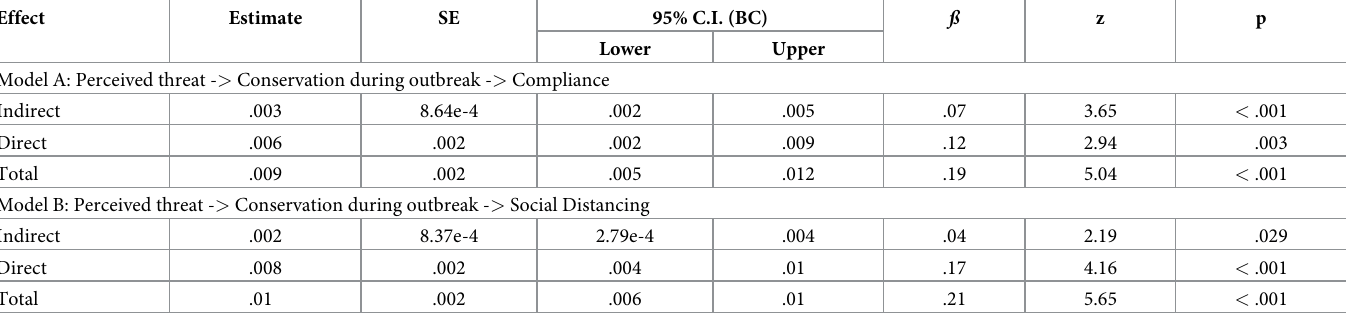
Table 5. Path-analysis models showing the direct, indirect, and total effect of perceived threat on compliance with movement restrictions (model A) and social dis- tancing (model B) via endorsement of conservation during Covid-19